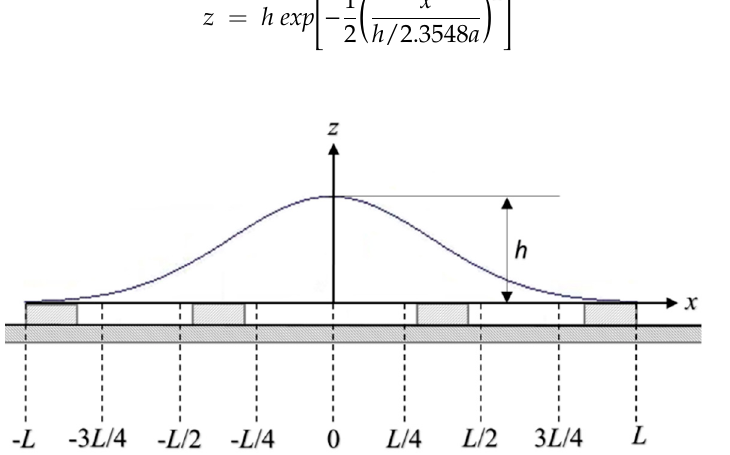
Figure 4. Schematic diagram of the two-dimensional hill model.